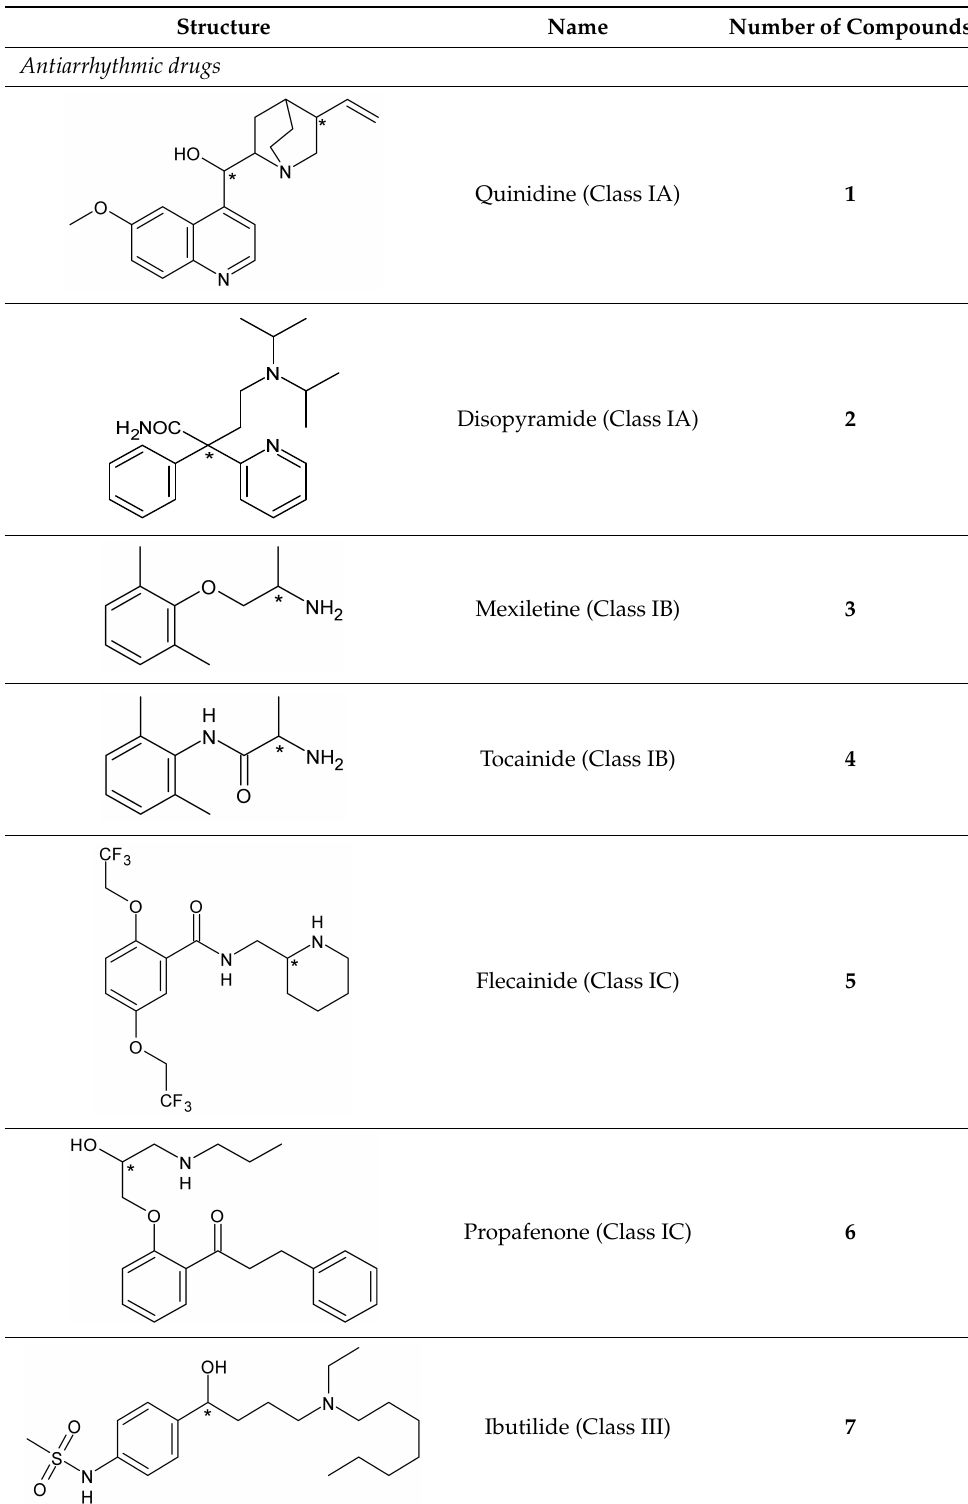
Table 1. Structures of chiral drugs in therapy.